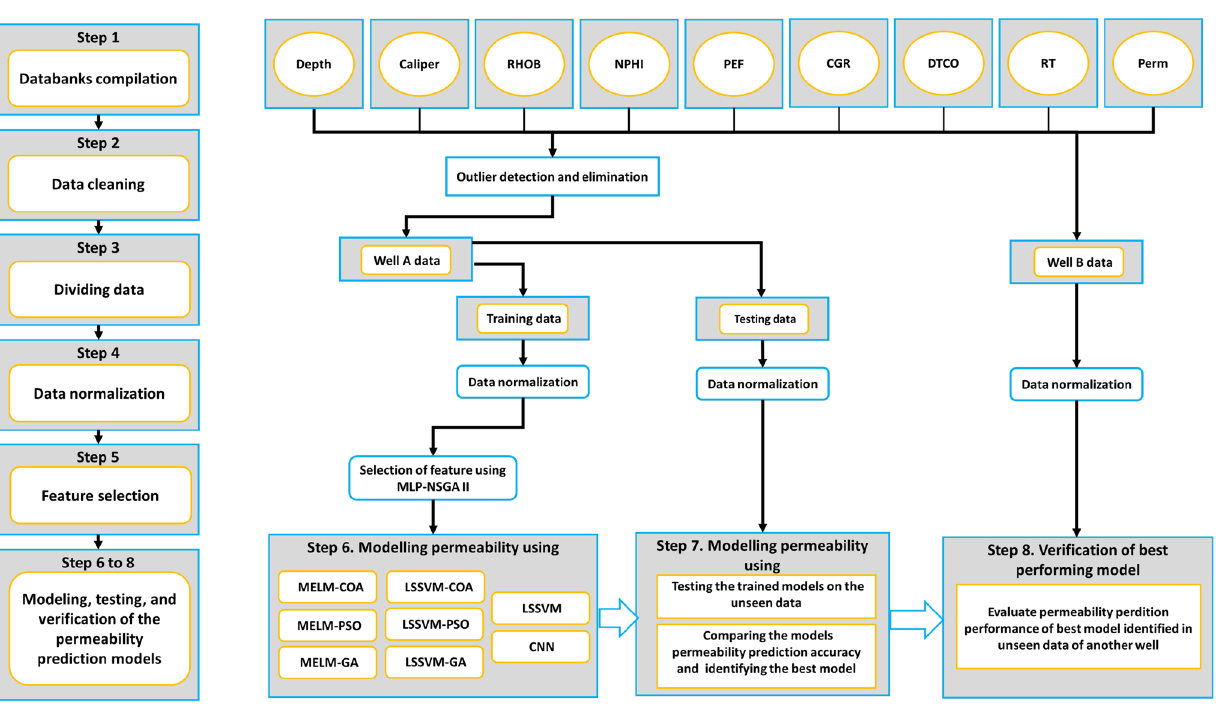
Fig. 1 Diagrammatic workflow representing the eight-step methodology used for developing, testing, and verifying intelligent models to predict